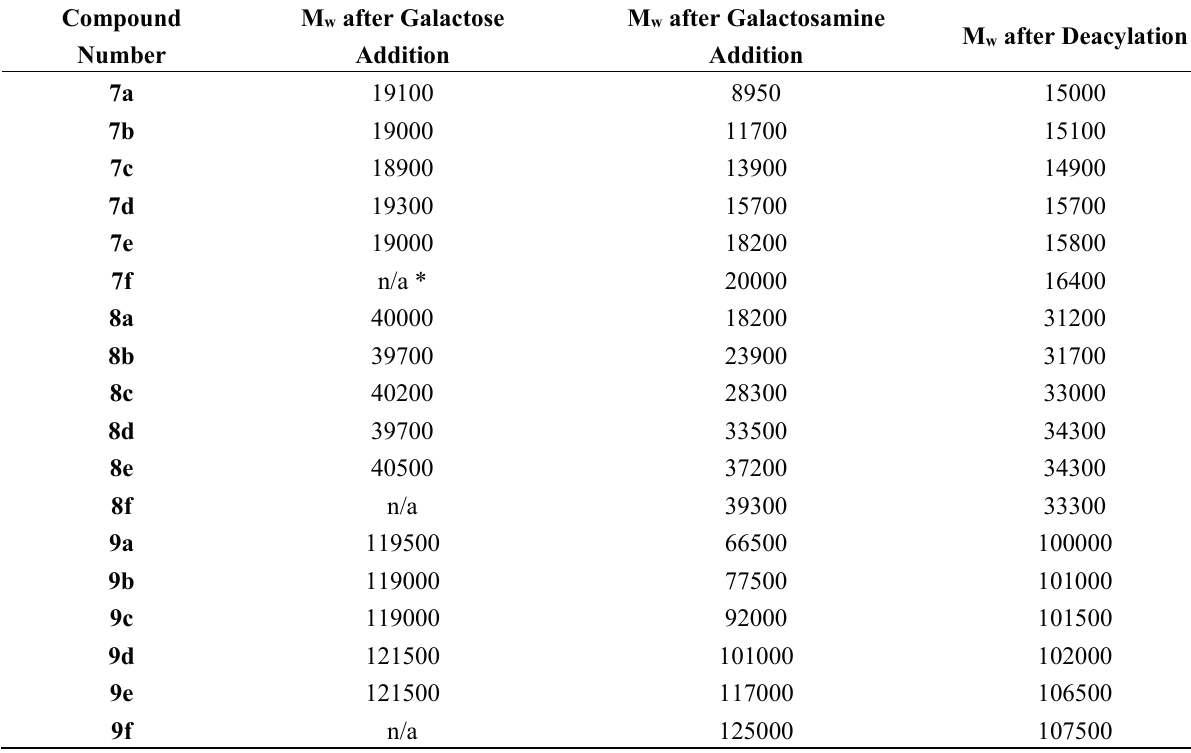
Table 7. MALDI-TOF MS data for heterogeneously functionalized dendrimers 7a – f , 8a – f and 9a – f .